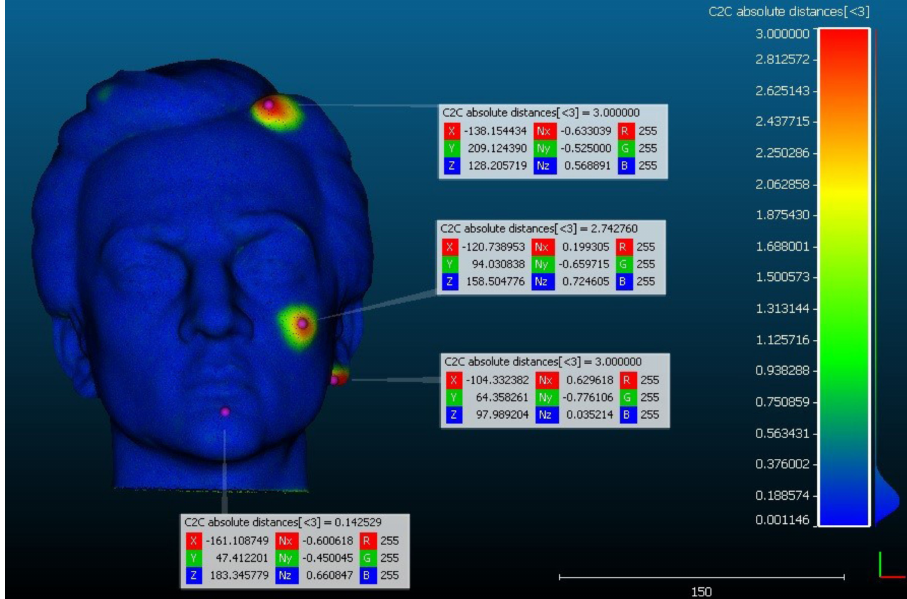
Figure 11. Results of the comparison of the models obtained by 3D scanning process in CloudCom- pare